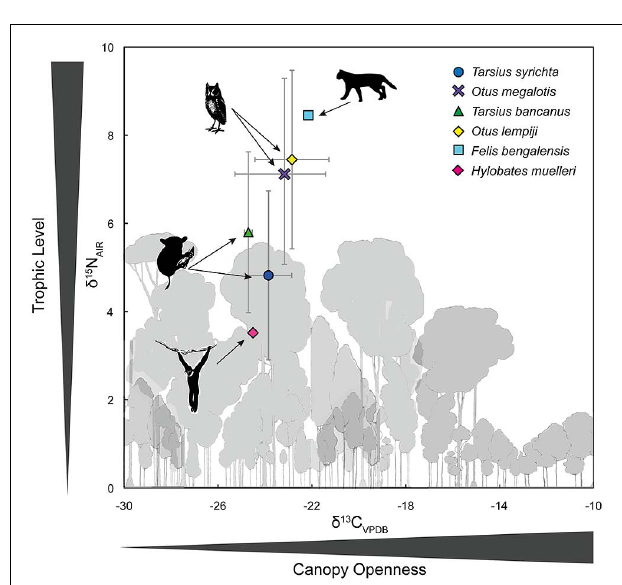
FIGURE 5 | Bivariate plot of δ 13 C and δ 15 N values (mean ± 1 SD) in the keratin of Bornean tarsiers ( Tarsius bancanus ), Philippine tarsiers ( T. syrichta ), Sunda scops owls ( Otus lempiji ), and Philippine scops owls ( O. megalotis ). To illustrate an approximate full dietary trophic step, the keratin-derived δ 13 C and δ 15 N values of a frugivore (Müller’s Bornean gibbon, Hylobates muelleri ) and a predator of vertebrates (leopard cat, Felis bengalensis ) from Sabah, northern Borneo are also